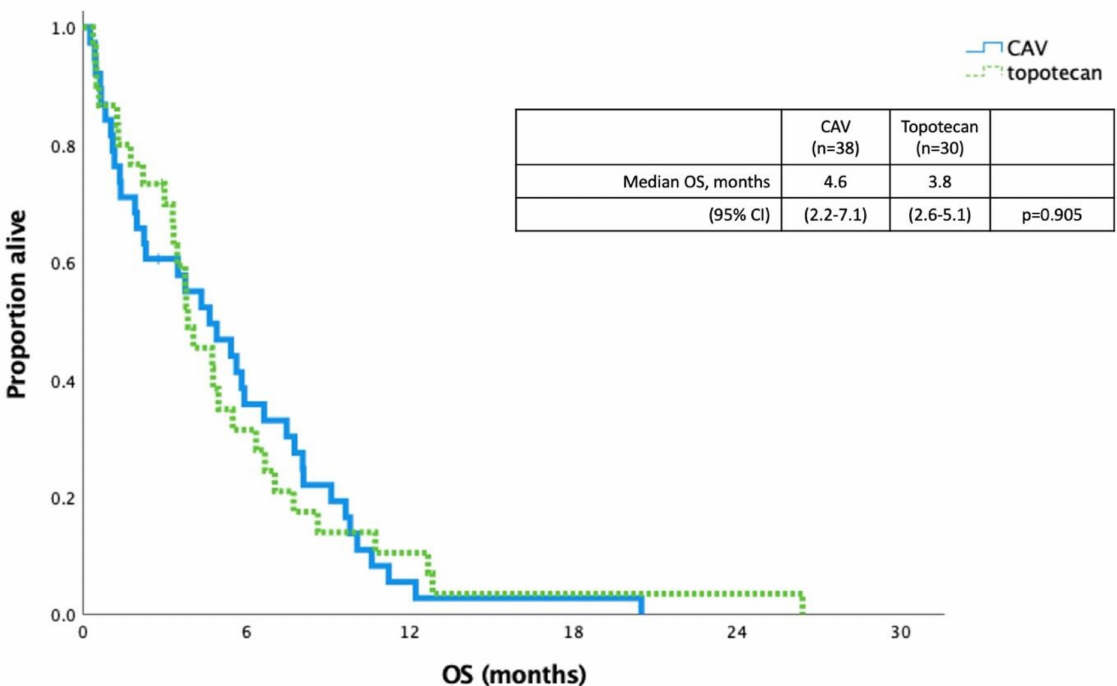
Figure 3. Kaplan–Meier curve for overall survival comparing patients who received second-line CAV versus